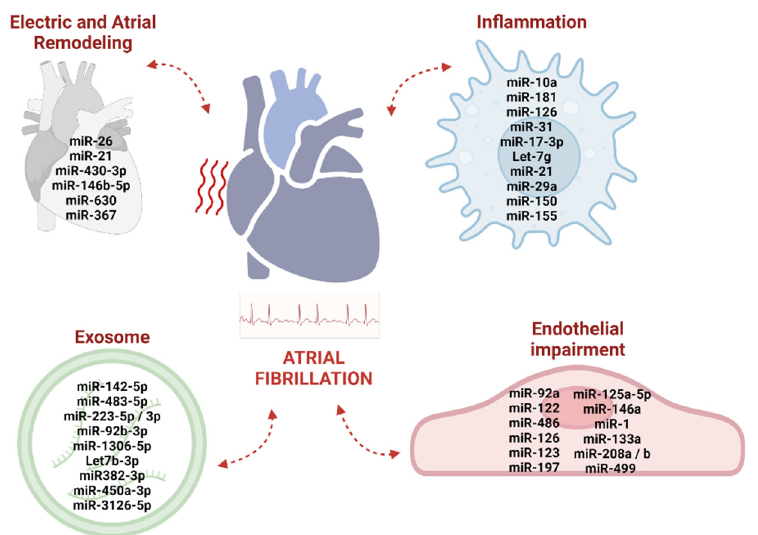
Figure 1. Schematic diagram highlighting the miRNAs most frequently associated with atrial fibrosis, vascular inflammation, and endothelial dysfunction, potentially contributing to AF onset and progression (description in the